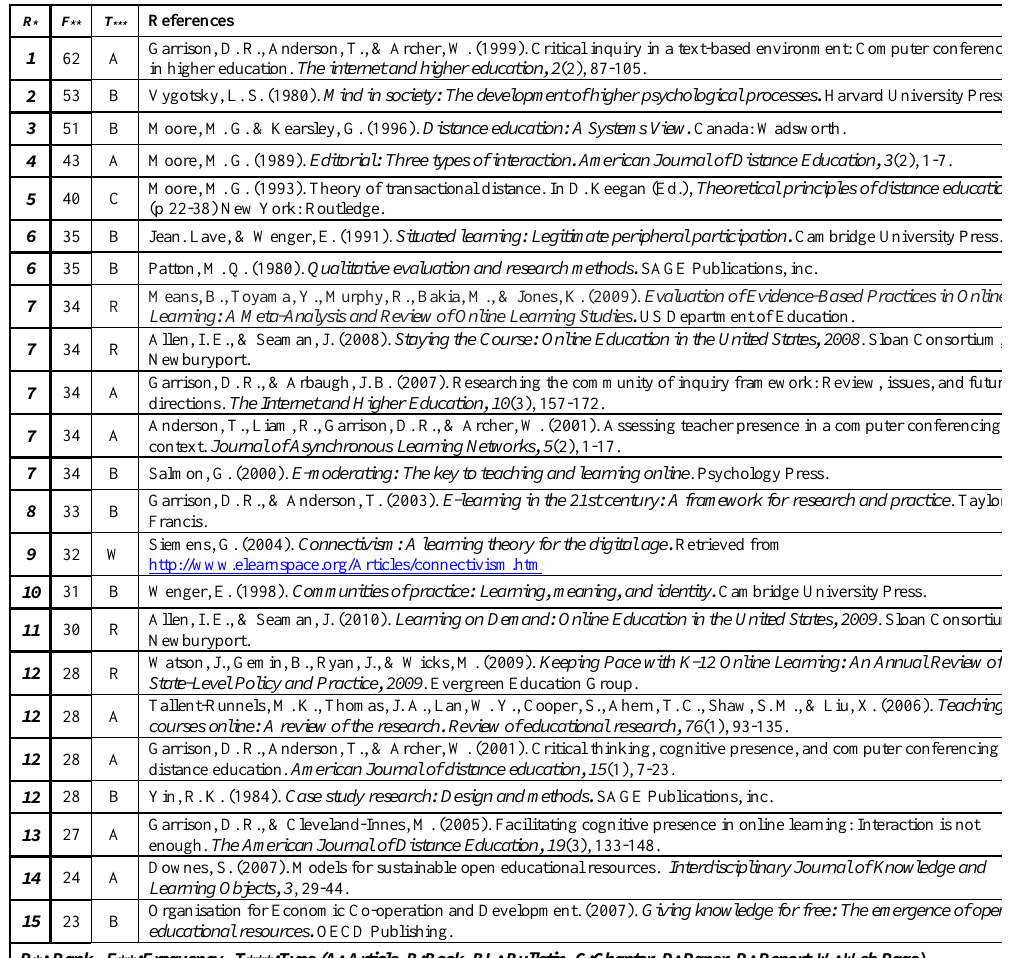
Table 10 The Reference List of Most Cited Studies (Top